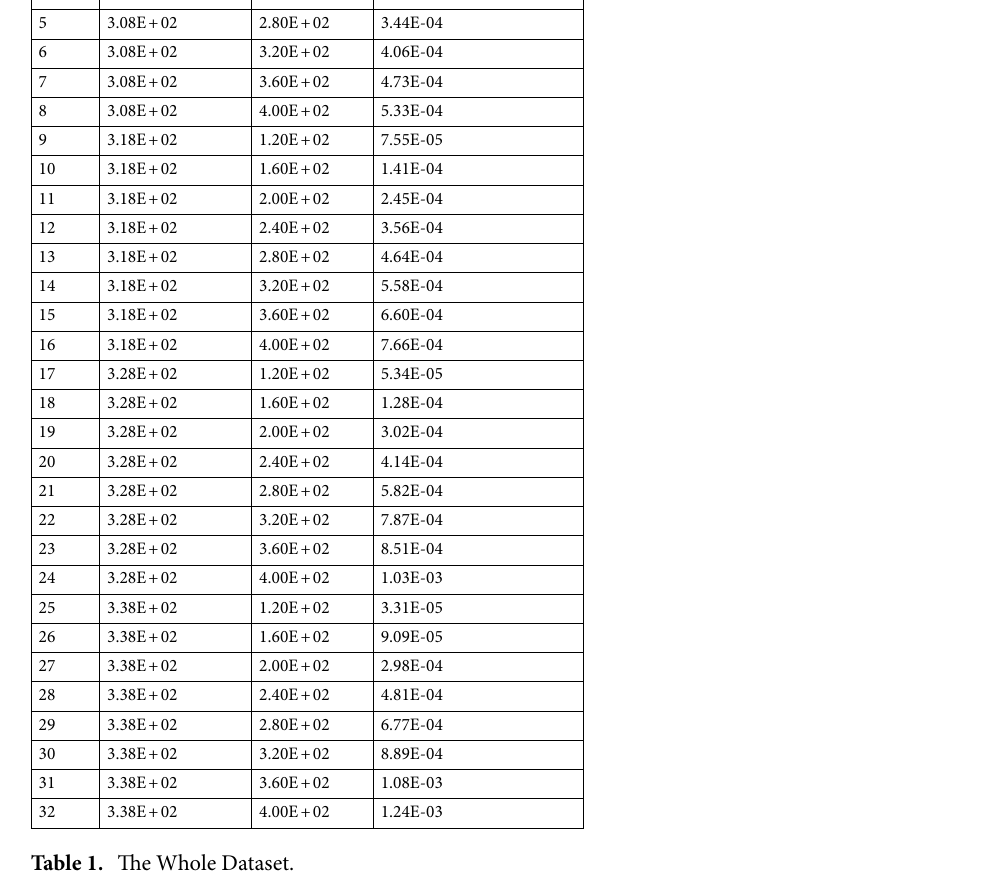
Table 1. The Whole